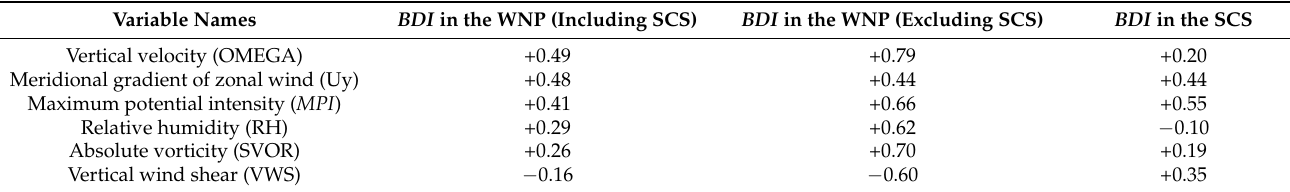
Table 3. BDI values of environmental factors in measuring the difference between years with high and low TC frequency in different sea